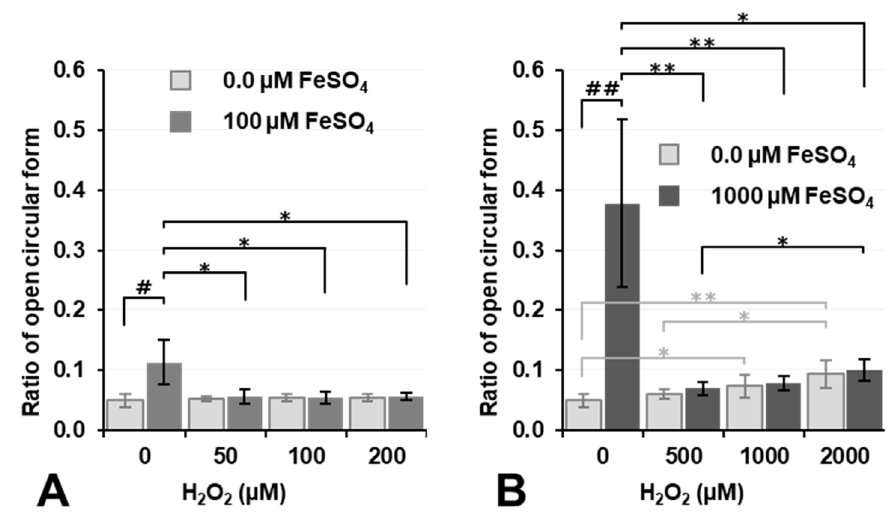
Figure 5. Estimation of plasmid DNA breakage induced by the Fenton reaction. ( A ) Ratio of DNA breakage after reacting 100 µ M FeSO 4 with several different concentrations of H 2 O 2 . ( B ) Ratio of DNA breakage after reacting 1000 µ M FeSO 4 with several different concentrations of H 2 O 2 . Columns and error bars indicate the average and SD of three experiments. Significant differences between different H 2 O 2 concentrations are indicated in the figure as * and **, which correspond to p < 0.05 and p < 0.01, respectively. Significant differences between different FeSO 4 concentrations are indicated in the figure as # and ##, which correspond to p < 0.05 and p < 0.01,